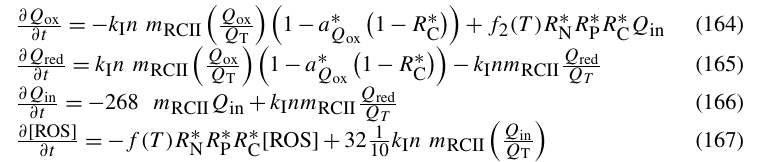
Table 28. Equations for symbiont reaction centre dynamics. Bleaching loss terms appear in Table 29.